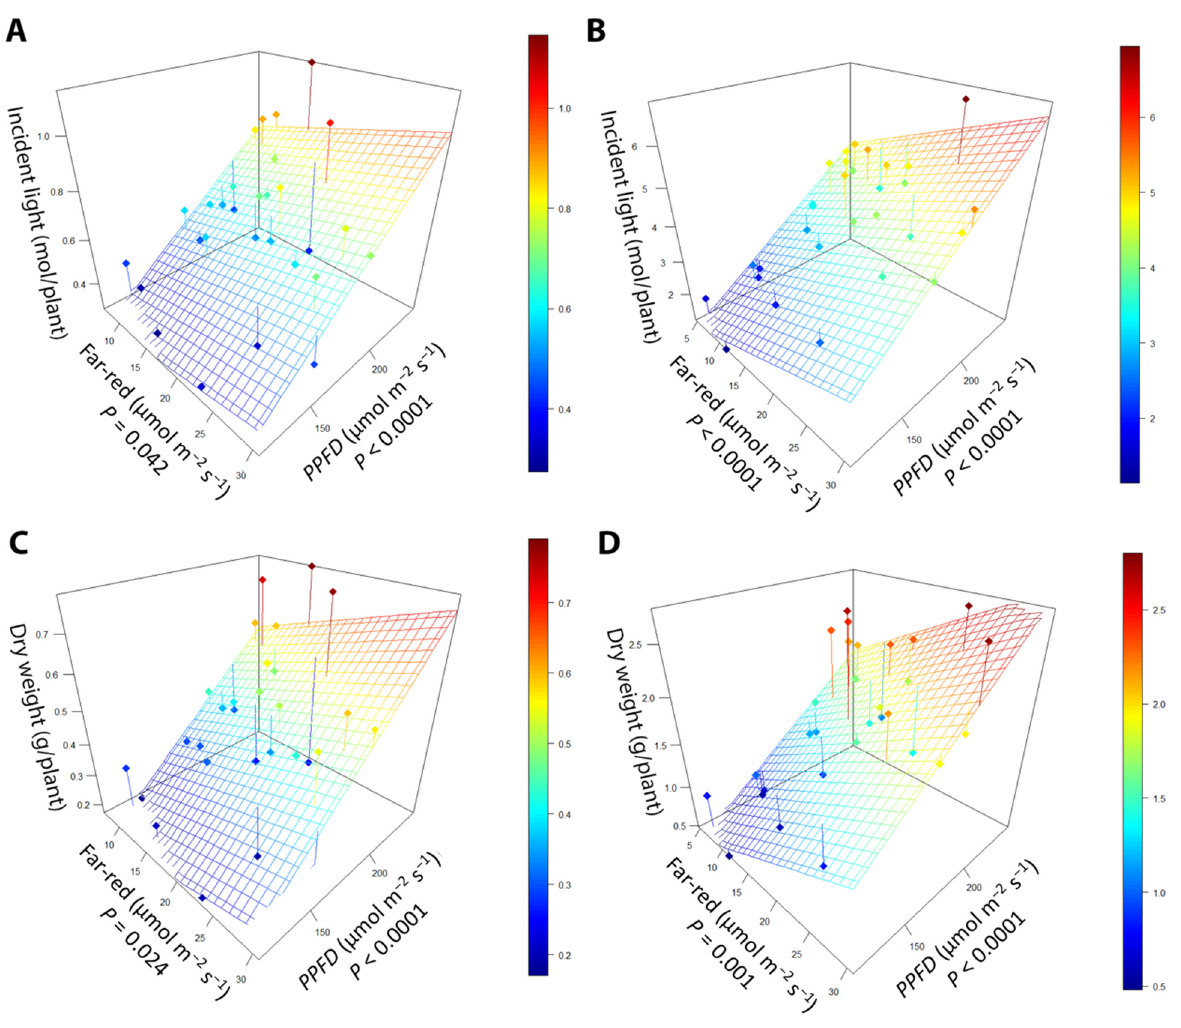
Figure 9. The relationship between supplemental far-red light intensity, photosynthetic photon flux density (PPFD), and incident light at ( A ) the early harvest and ( B ) the late harvest. The relationship between far-red light intensity, PPFD, and dry weight in ( C ) the early harvest and ( D ) the late harvest. “Green Salad Bowl” lettuce ( Lactuca sativa ) plants were grown under a PPFD ranging from 111 to 245 µ mol m − 2 s − 1 and a perpendicular far-red gradient ranging from 4.7 to 32.8 µ mol m − 2 s − 1 . The early harvest occurred 16 days after germination, while the late harvest occurred 25 days after germination. Table 1. Regression equation intercepts and coefficients for dry weight (g/plant), cumulative inci- dent light (mol/plant), leaf length (cm), and leaf width (cm) for the early and late harvests, as a function of the far-red (FR) light level (µmol m − 2 s − 1 ) and photosynthetic photon flux density (PPFD, µmol m − 2 s − 1 ).